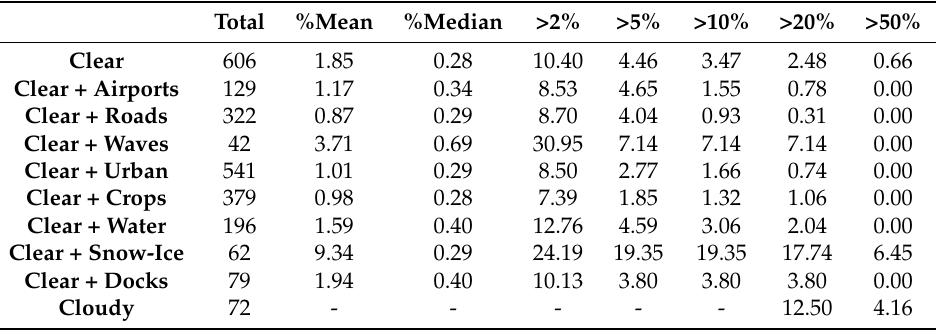
Table 2. Full results of the Carbonite-2 experiments. Mean and median columns give respective error percentages. ‘ > x %’ columns give percentage of frames for which the error was higher than x . The results show a significantly skewed error population, with mean error consistently much large than median, showing that for the half the frames the accuracy is exceptionally good ( <